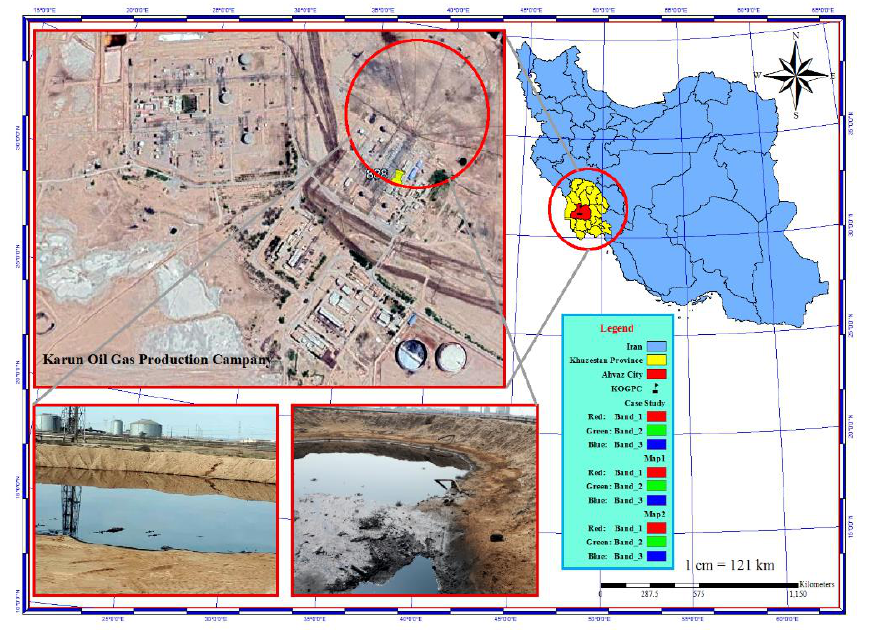
Fig. 1. Area study; Karun Gas Oil Production Company,